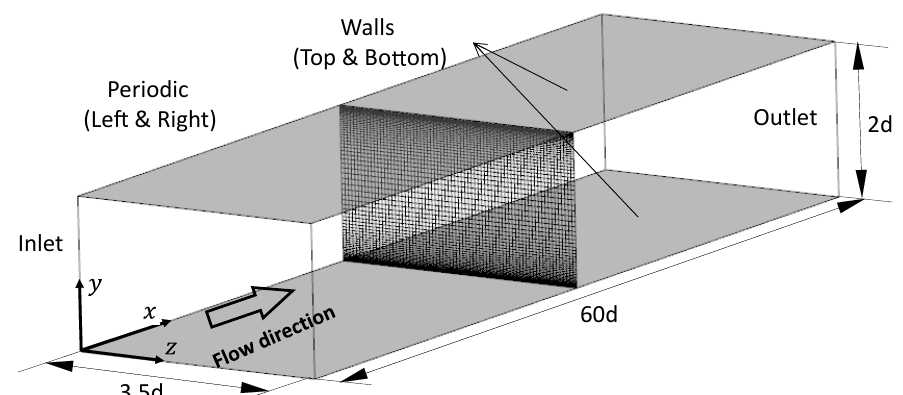
Figure 1. Schematic diagram of the computational domain (total number of cells: 600 × 60 ×